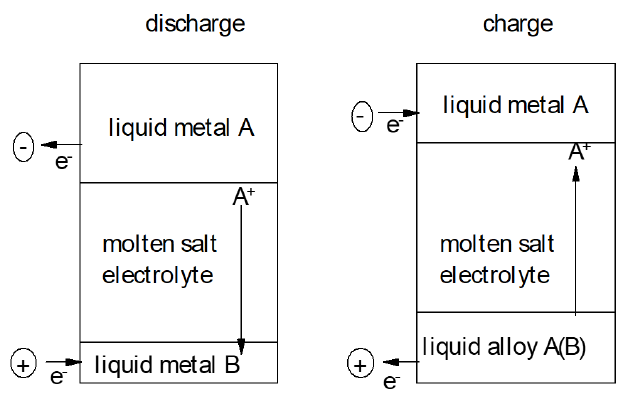
Figure 1. Operating principle of a LMB.